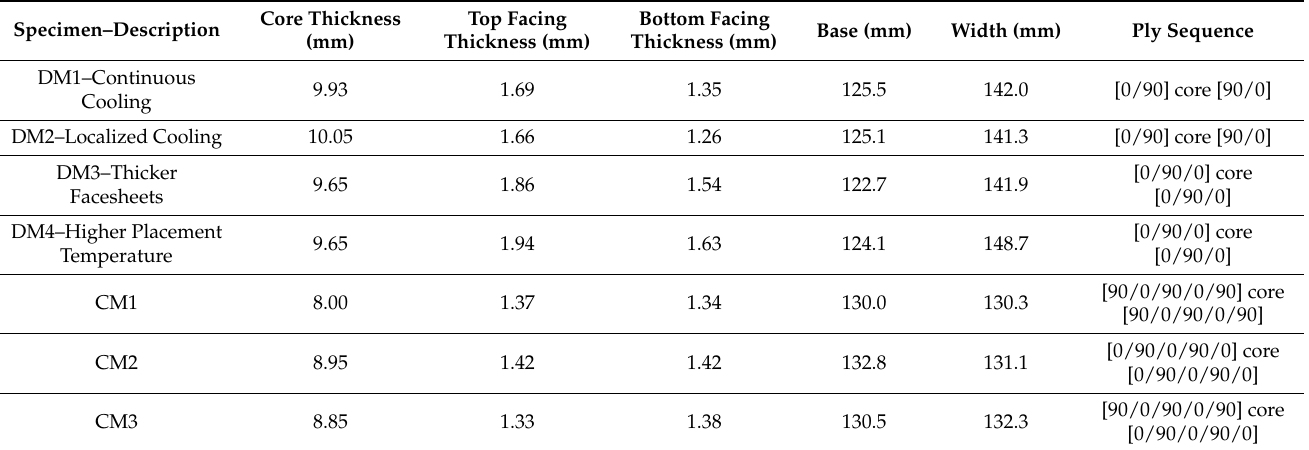
Table 1. Sandwich Panel Navtruss Core Specimen